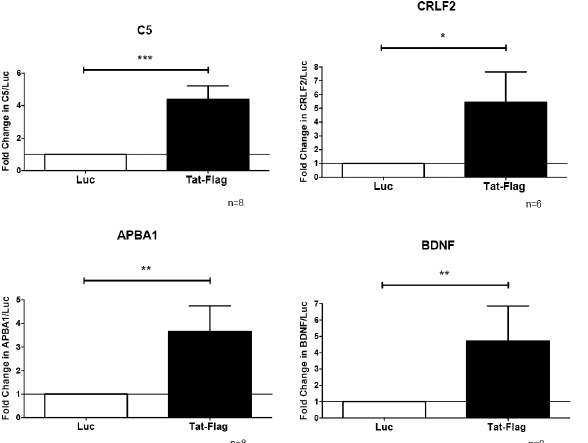
Fig 3. Tat complex binds to the human macrophage genome at C5, CRLF2, APBA1, and BDNF. THP- 1-Tat-Flag and THP-1-luciferase cell lines generated from 5–6 independentsets of infection and selection were treated with PMA for 24 hours, cell lysates were prepared,and immunoprecipitatedwith antibody to Flag, followedby qPCR analysis. For qPCR analysis,we used the specific sequencesin the genome identifiedby ChIP-seq and designedspecific primers for these regions for the 4 genes(C5, CRLF2, APBA1, and BDNF). The precipitatedDNA and input were then quantifiedby real-time PCR. Quantificationis expressedin arbitrary units indicatingfold over control (Luc), and target sequencelevels were normalizedto the input using the method of Pfaffl. Tat complex significantly boundto the 4 humanmacrophages genes selected, C5, CRLF2, APBA1, and BDNF. Significance was determined using a Wilcoxon signed-ranktest. Error bars represent the median ± S.D.; * P < 0.05, ** P < 0.01.